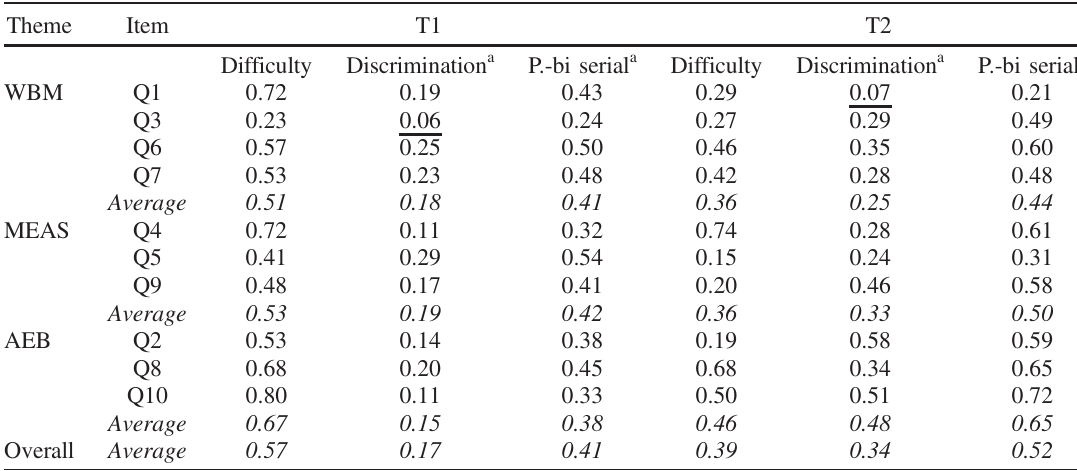
TABLE V. Classic test theory statistics for QME (tiers analyzed individually).